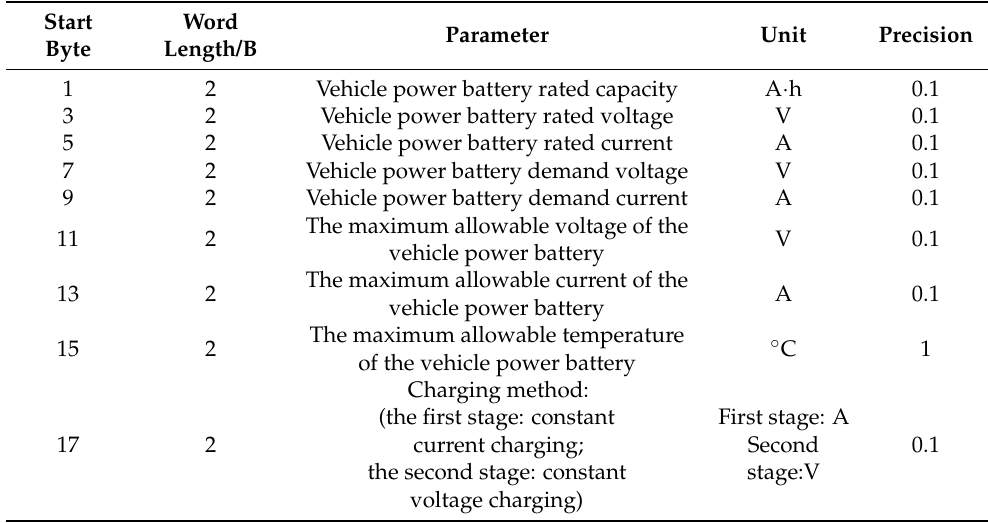
Table 1. Main status information before charging of the electric vehicle battery.